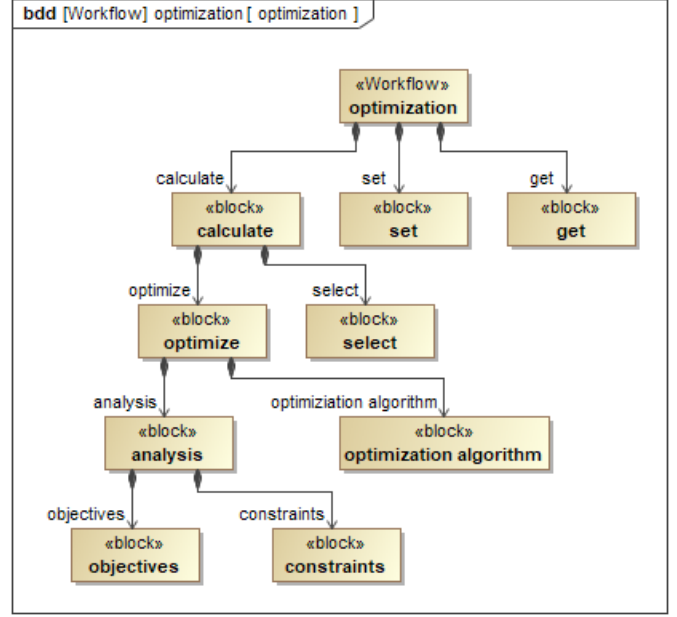
Figure 10. Architecture of the Optimization Workflow.